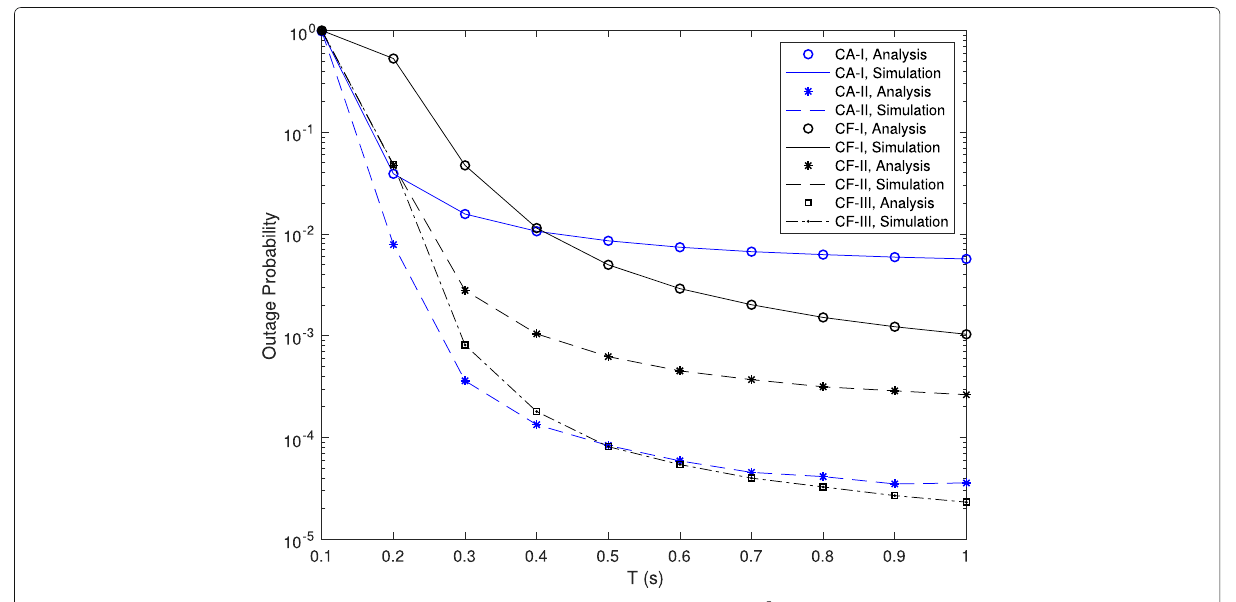
Fig. 3 Outage probability versus T when N = 2, L = 50Mbits, K = 10, B = 100MHz and P /σ 2 = 15dB